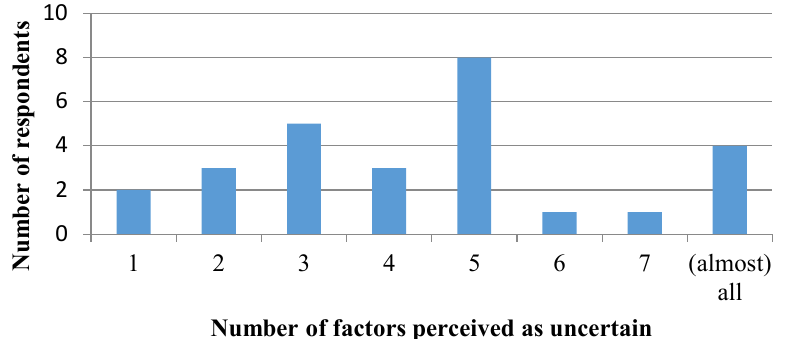
Figure 4. Number of factors perceived as uncertain by the respondents ( N = 27).